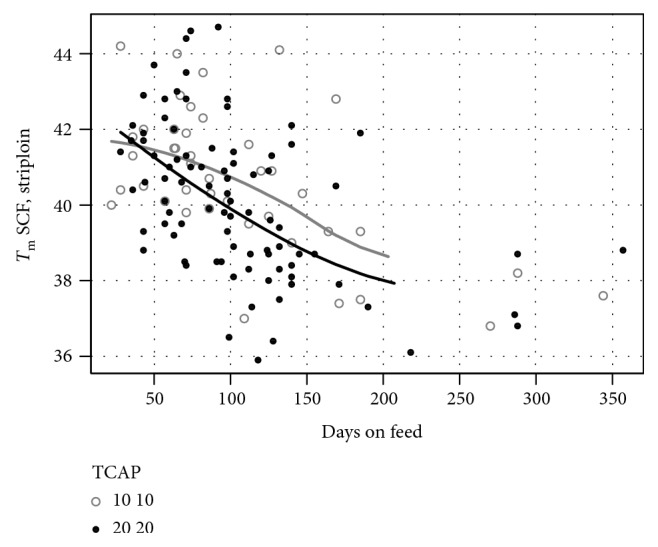
TCAP 20 homozygotes achieve low Tm with less days on feed (Melaleuka crossbreds). TCAP 20 homozygotes (filled circles) achieve low Tm with less days on feed. Hollow circles show TCAP 10 homozygotes. The smoothed lines were calculated in R with a span of 100. Tm measured on various European and Japanese breeds and crossbreeds including Simmental, Gelbvieh, black Wagyu, and red Wagyu. Subcutaneous fat samples were taken from the rump and front ends of striploins, with the Tm reported as the average of the two samples. Striploins were DNA tested to confirm a match to the animal sent to abattoir. 42 samples from TCAP 10 homozygotes and 87 samples from TCAP 20 homozygotes are shown. Tm measurements of 105 samples from TCAP 10,20 heterozygotes have been excluded from the graph for simplicity.